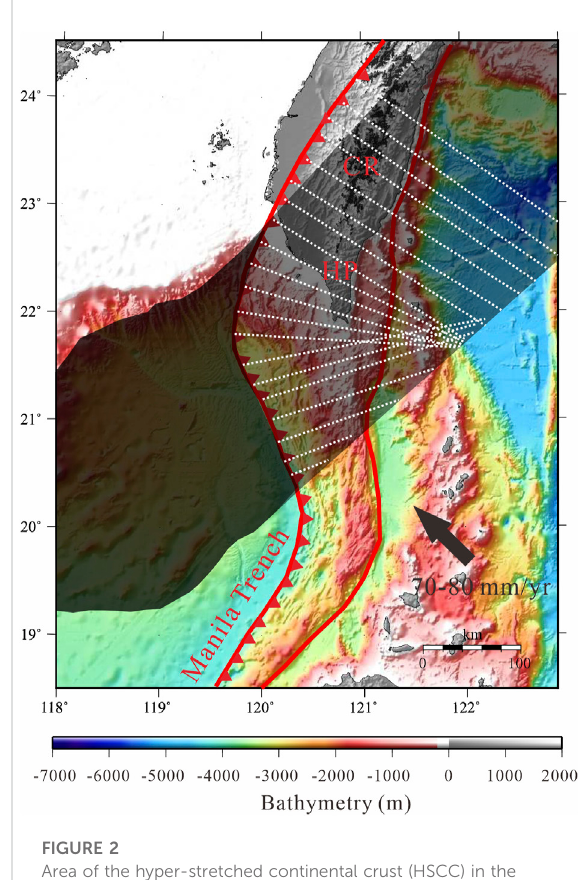
FIGURE 2 Area of the hyper-stretched continental crust (HSCC) in the study region. The distribution of HSCC to the east of the Manila Trench was simply extended following the trend of HSCC west of the trench. HSCC subduction normal to the trench is indicatedbywhitedashedlines.Owingtodifferenttrendsbetween the trench and the HSCC, an increasing amount of HSCC subduction occurs from Hengchun Ridge to Hengchun